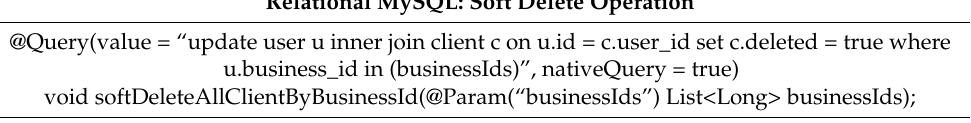
Table 14. Soft delete operation.